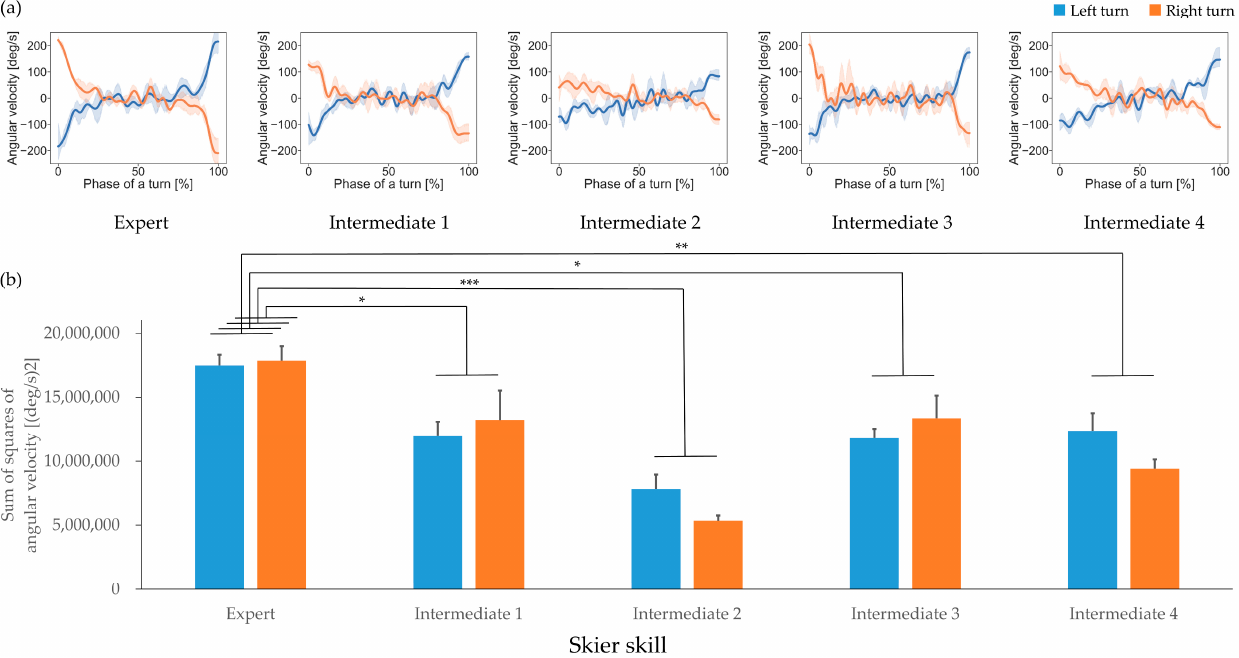
Figure 6. ( a ) Ski motion, demonstrated by edge rotation angular velocity, for each participant and ( b ) its representative quantitative feature. Blue and orange represent left and right turns, respectively. Statistical significance is indicated with * p < 0.05, ** p < 0.01, *** p < 0.001. Table 1. Results of the post-hoc comparisons for the quantitative ski motion feature. The expert skier was compared to each intermediate skier.